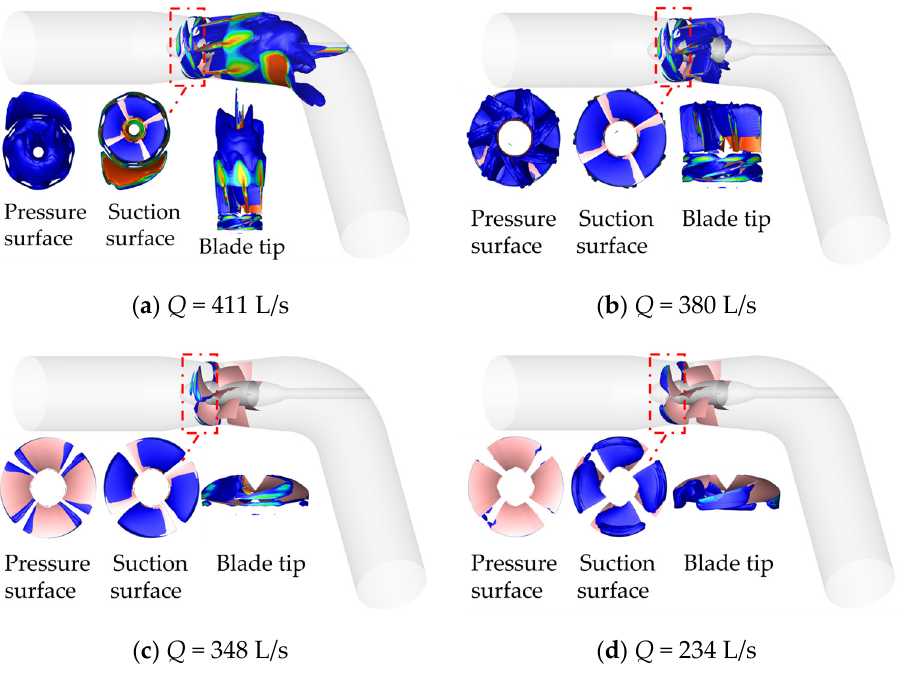
Figure 15. Air bubble distribution volume cloud diagrams at p in = 4 × 10 4 Pa.